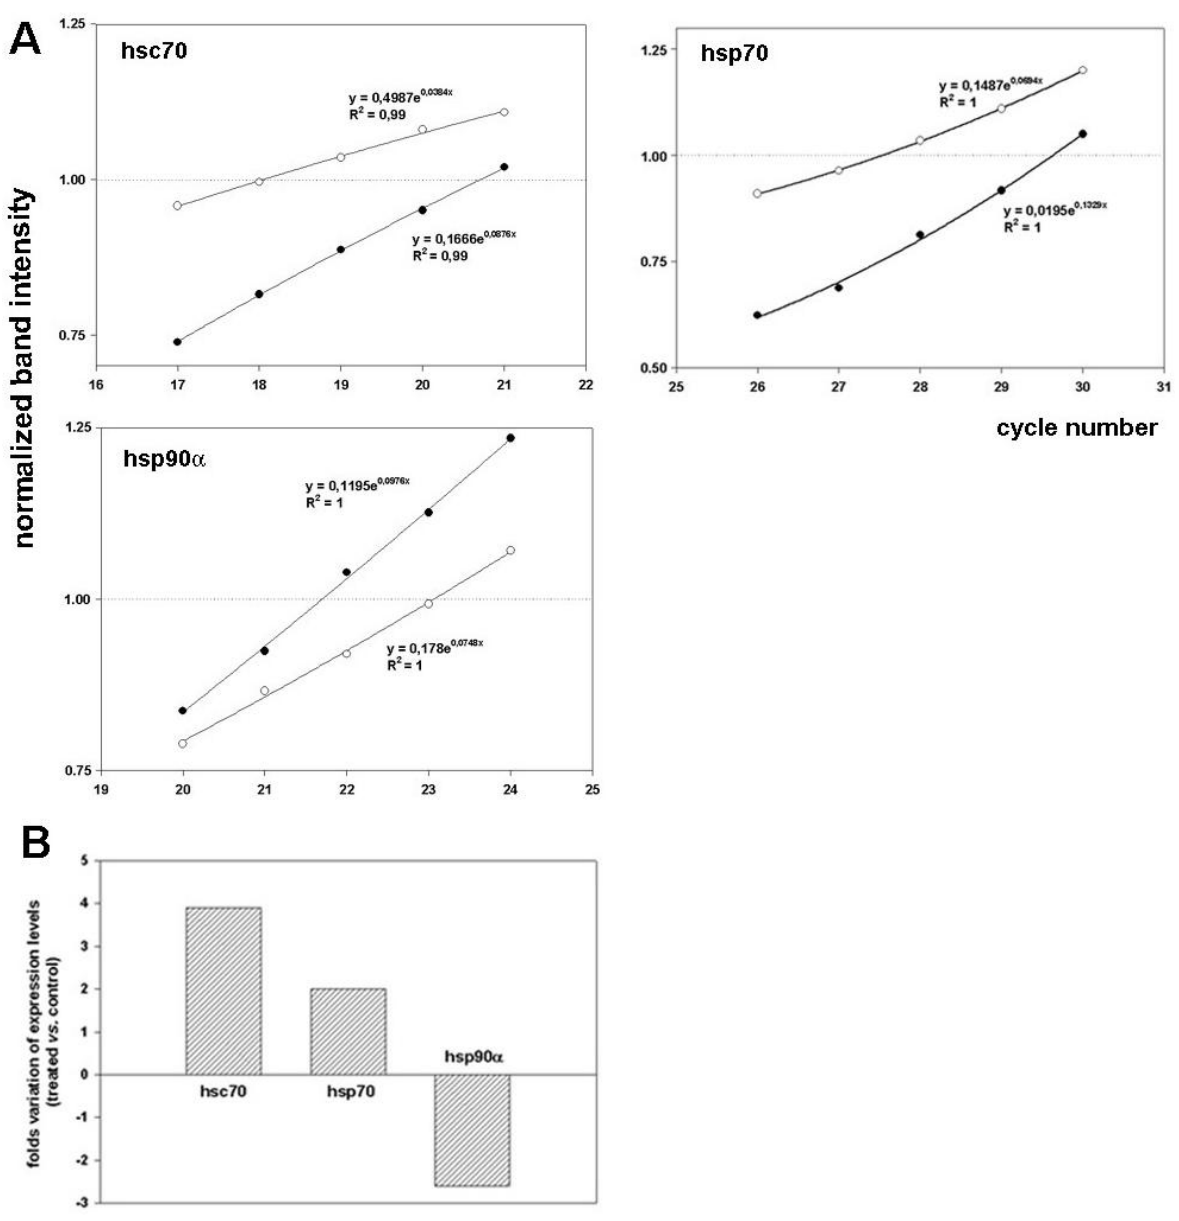
FIGURE 4. (A) SM-PCR for stress response genes hsc70 , hsp70, and hsp90  . Representative plots of normalized data vs. cycle number fit with an exponential curve for control (●) and midregion PTHrP-treated (○) MDA-MB231 cells. (B) Histogram showing changes of gene expression levels in treated MDA-MB231 cells vs. controls, as resulted from SM-PCR